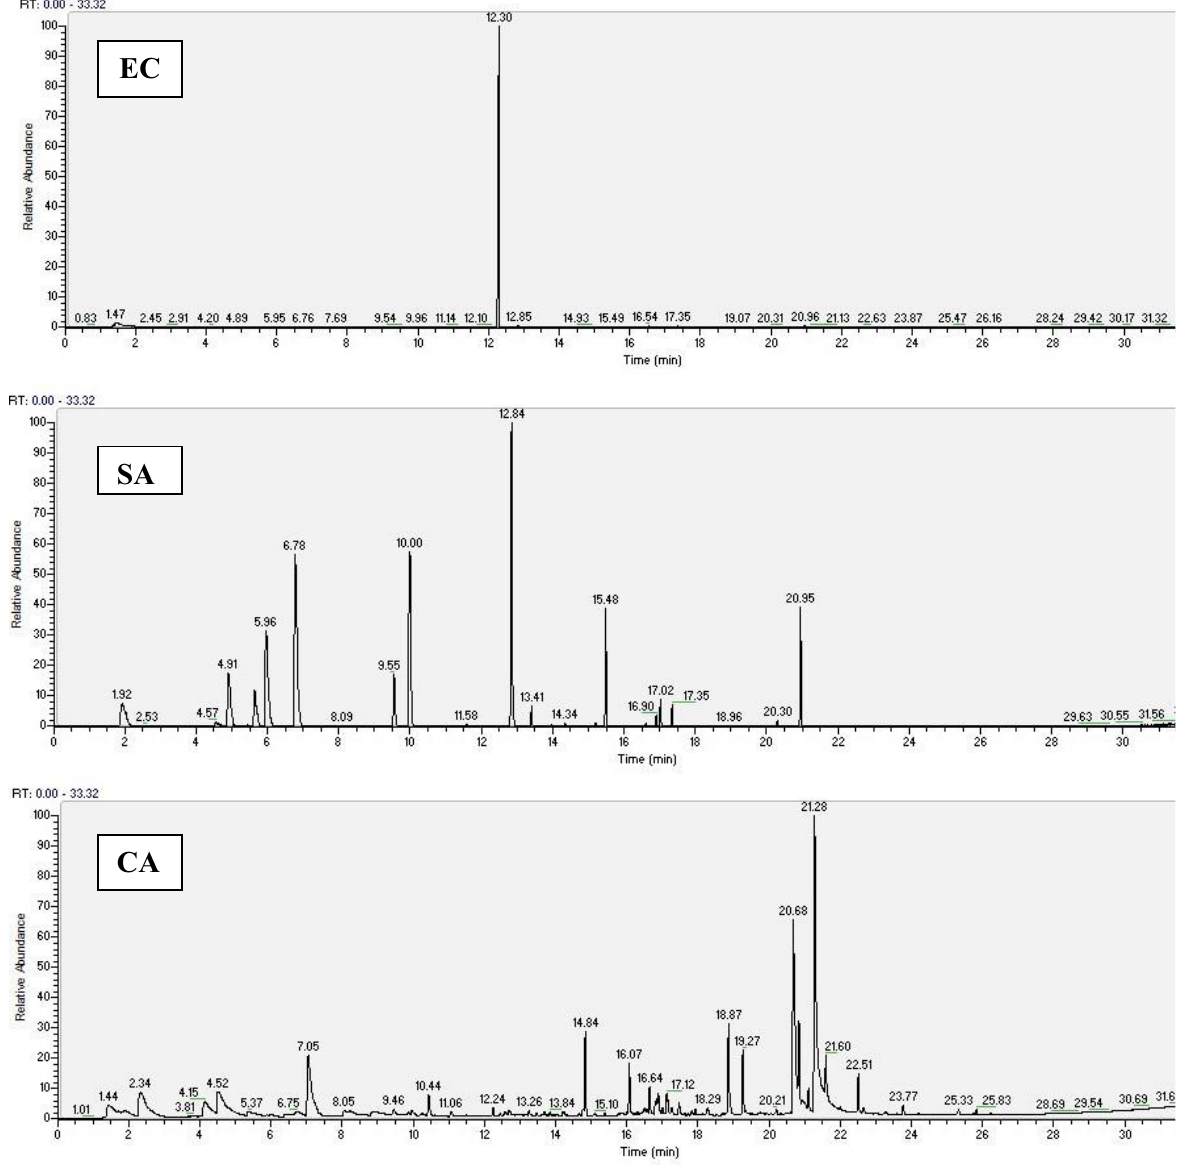
Figure 1. Three chromatograms, for samples taken 4 hours after culture in TSB media. EC: E. coli, SA: S. aureus and CA: C. albicans. The other chromatograms are available in the Supplementary